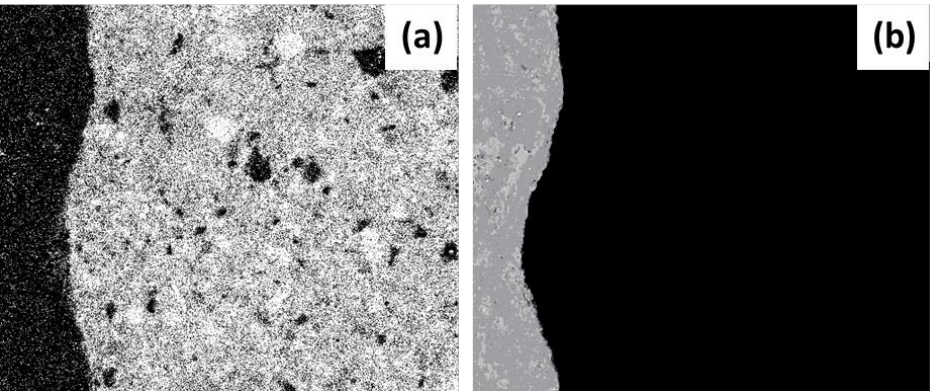
Figure 5. Elaboration of the mask of the paste for the sample RCA 50 C ( a ) image after the operating instructions and ( b ) after the morphological filters.